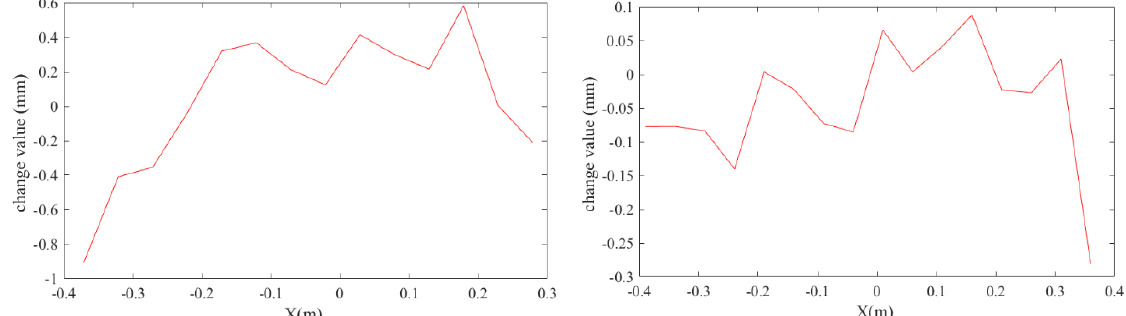
Figure 6. Change profile along the X axis (left for slope 1 and right for slope 2), i.e. the across flume direction. A change value at a given X location, is obtained by averaging all changes for the corresponding Y values. It is assumed that these profiles are affected by some leakage that took place at the side of the